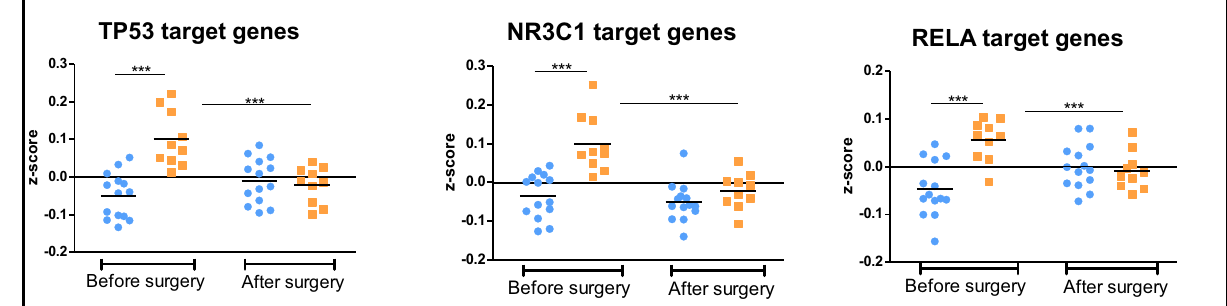
Fig. 3 TP53, NR3C1, and RELA pathways differentiate MDD (orange symbols) from non-depressed patients (blue symbols) at baseline and are normalized after surgery. Two-way ANOVA followed by Bonferroni post hoc tests, *** p <